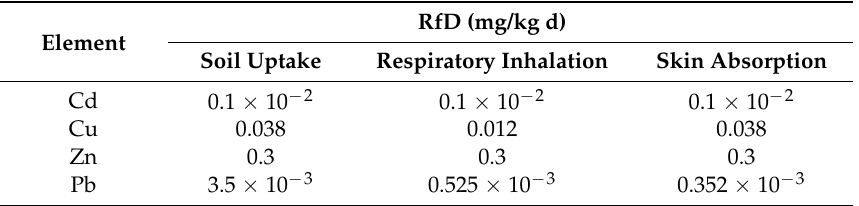
Table 3. Health hazard assessment parameters of Potentially Toxic